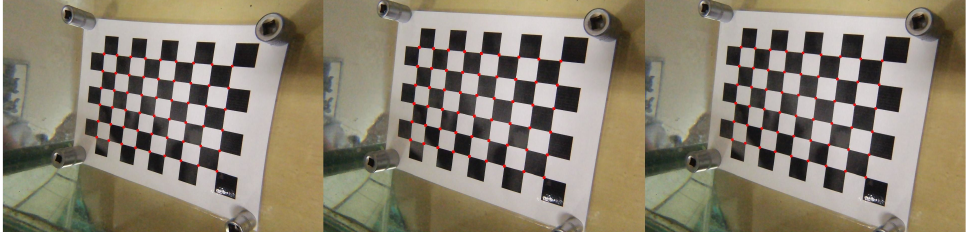
Figure 4. Examples of images (from left to right): Taken underwater (salinity < 1%) with parameters for correcting radial distortion when shooting in air; corrected using the classical calibration method; and corrected by Formula